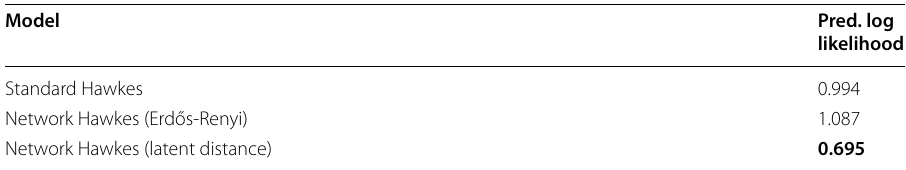
This table represents errors of three models relative to a homogeneous Poisson process on a task of predicting next news event for a company. Bold value represents which model had the largest improvement in error over baseline